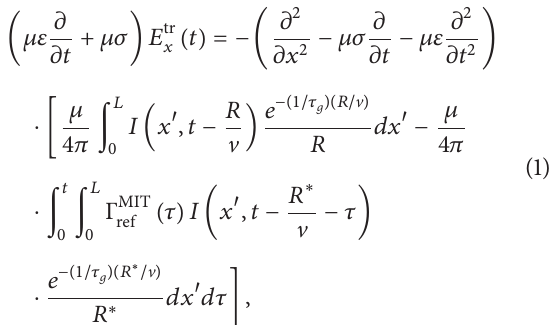
Direct time domain formulation for the transient